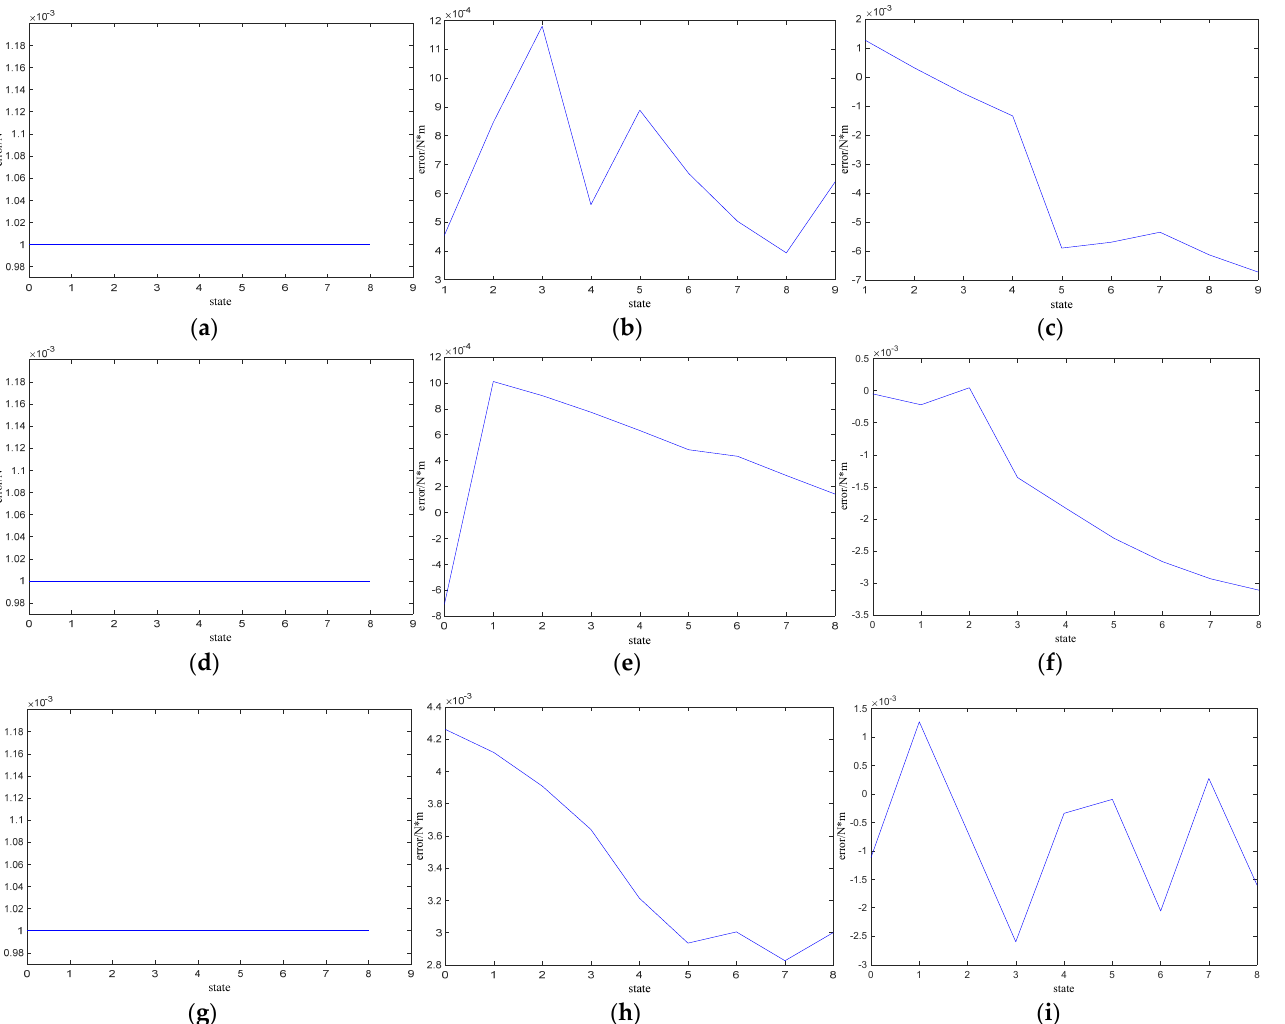
Figure 15. Errors of simulation 3, simulation 4 and simulation 5. ( a ) Upper chain in simulation 3. ( b ) Bottom chain 1 in simulation 3. ( c ) Bottom chain 2 in simulation 3. ( d ) Upper chain in simulation 4. ( e ) Bottom chain 1 in simulation 4. ( f ) Bottom chain 2 in simulation 4. ( g ) Upper chain in simulation 5. ( h ) Bottom chain 1 in simulation 5. ( i ) Bottom chain 2 in simulation 5.